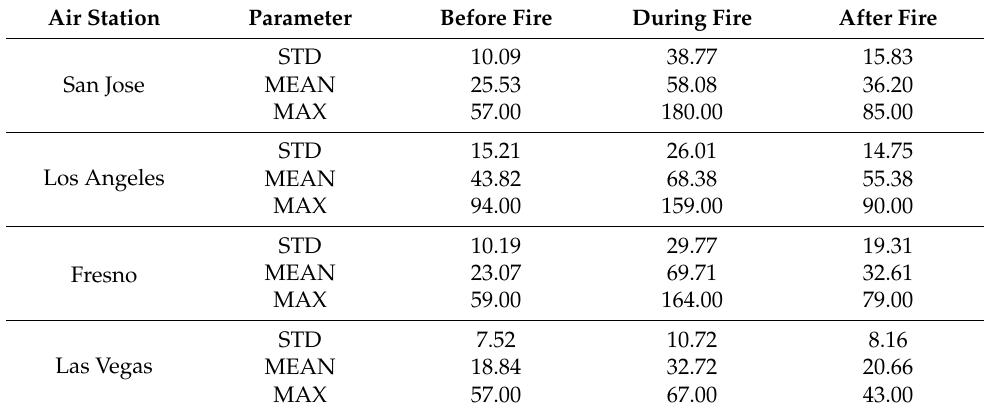
Table 6. The PM10 statistics of air quality stations in different fire periods ( µ g/m 3 ). Air Station Parameter Before Fire During